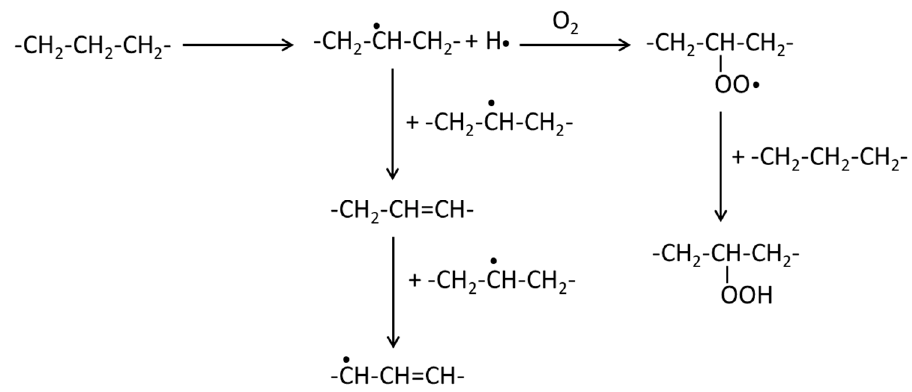
Scheme 1. Simplified diagram of radical reactions in AO non-protected